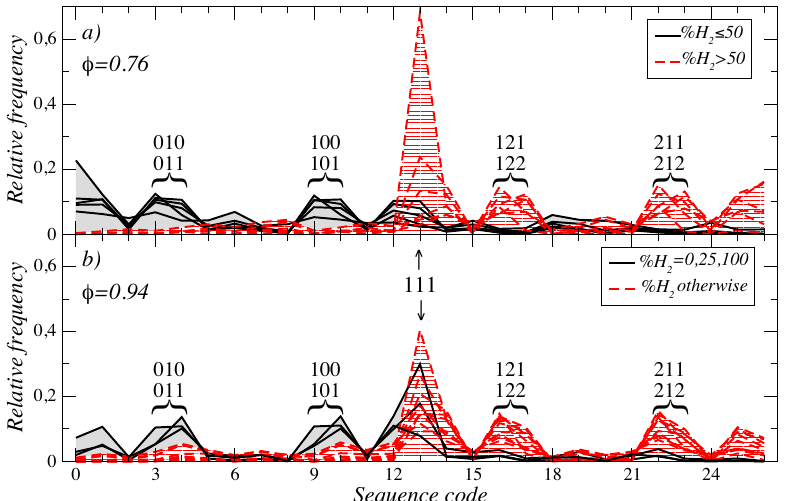
Figure 11. Symbol sequence histograms of the Q r sequence for all values of hydrogen concentrations for particular fuel ratios: ( a ) a lean mixture, φ = 0.76; ( b ) a close-to-stoichiometric one φ = 0.94. Parameters for calculations are n = 3, L = 3.